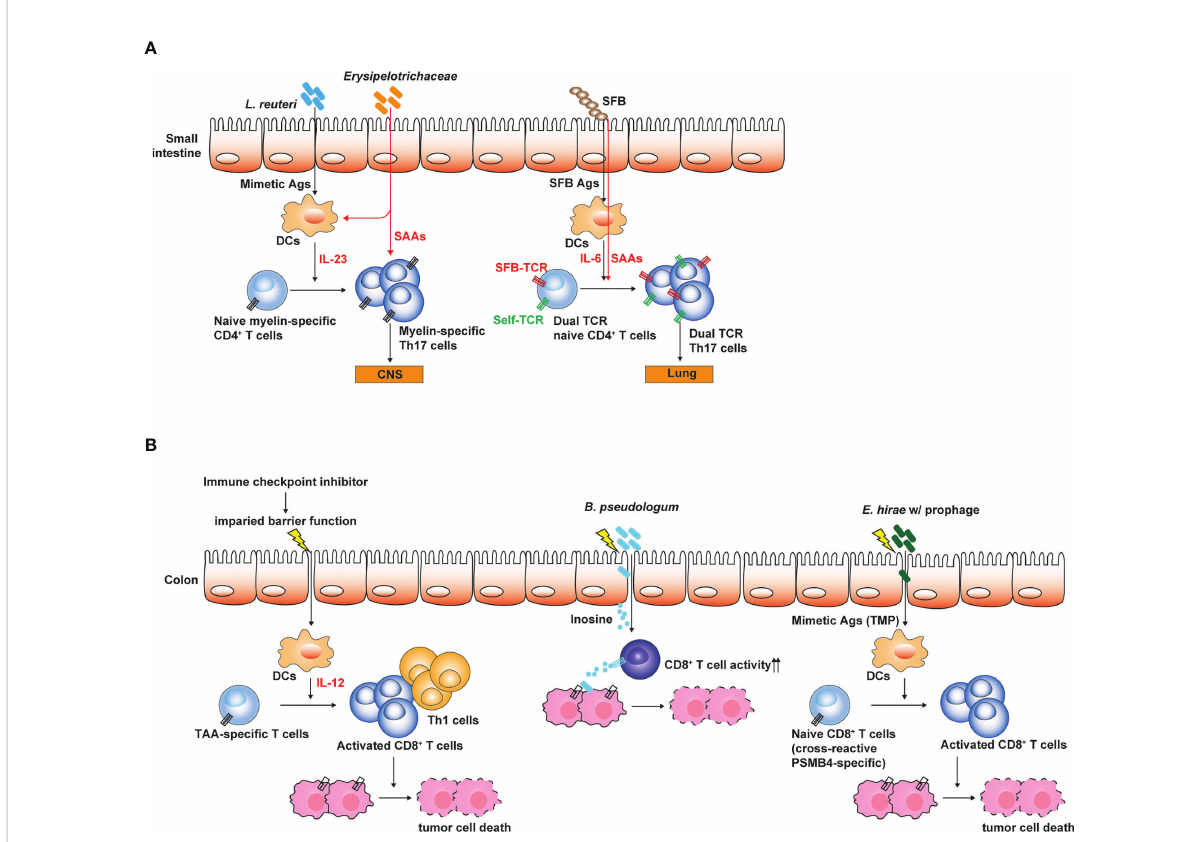
FIGURE 2 In fl uences of gut microbiota on the pathogenesis of autoimmune disease and tumors. (A) Small intestinal Th17 responses are linked to the susceptibility to Th17-mediated autoimmune disease such as EAE. Antigenic mimicry between microbial Ags and self-Ags is one of the mechanisms through which gut microbiota in fl uences the induction and the pathogenesis of Th17-mediated autoimmune diseases. Myelin- speci fi c CD4 + T cells expand by microbial mimetic Ags and are conditioned to differentiate into Th17 cells. Alternatively, T cells expressing dual TCRs speci fi c to both SFB Ag and self-Ag proliferate and differentiate into Th17 cells, and then induce autoimmunity in extra-intestinal tissues. (B) Gut microbiota determines the responsiveness to ICI treatment. Weakening intestinal barrier functions by the ICI treatment leads to the translocation of gut microbes and enables gut microbes to promote Th1 and cytotoxic T cell responses against TAA by conditioning intestinal DCs. Bi fi dobacterium spp. enhance the cytotoxic activity of TAA-speci fi c CD8 + T cells by producing inosine. E hirae produce mimetic Ag (TMP) which can proliferate cross-reactive TAA (PSMB4)-speci fi c CD8 + T cells, thereby enhancing the ef fi cacy of ICI treatment. The fi gure was created with Adobe